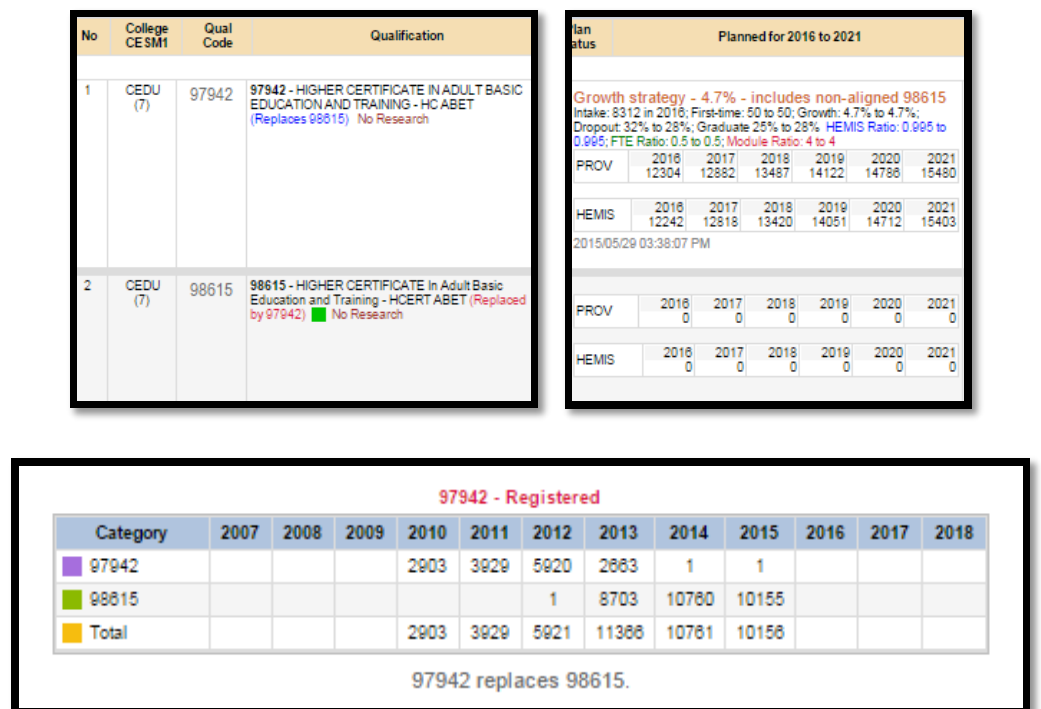
Figure 6. Three Excerptsof the Digital DNA 2 equivalence view.